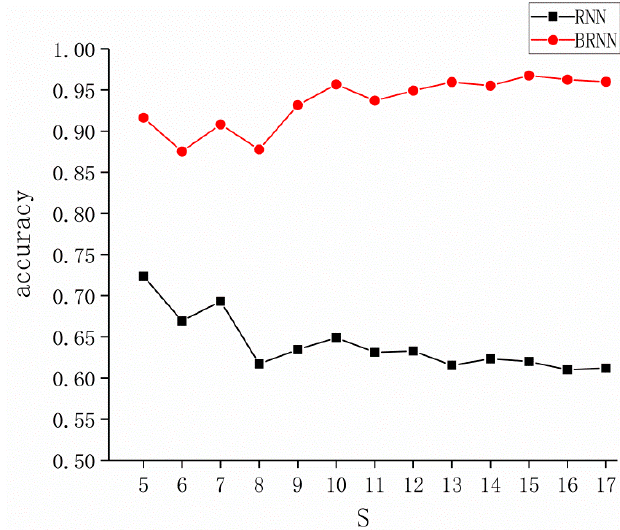
Figure 15. Accuracy of the model for different 𝑠 values